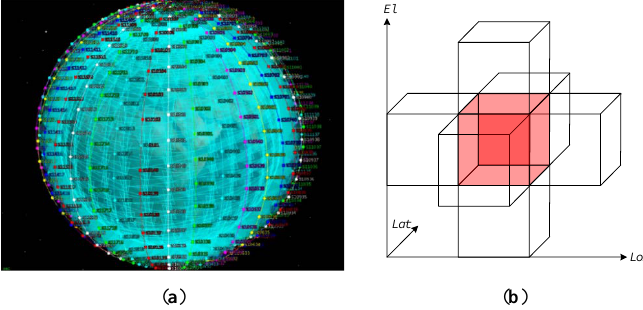
Figure 6. Grid network topology model: ( a ) LEO (low earth orbit) satellite constellation; ( b ) Six cell neighborhood.